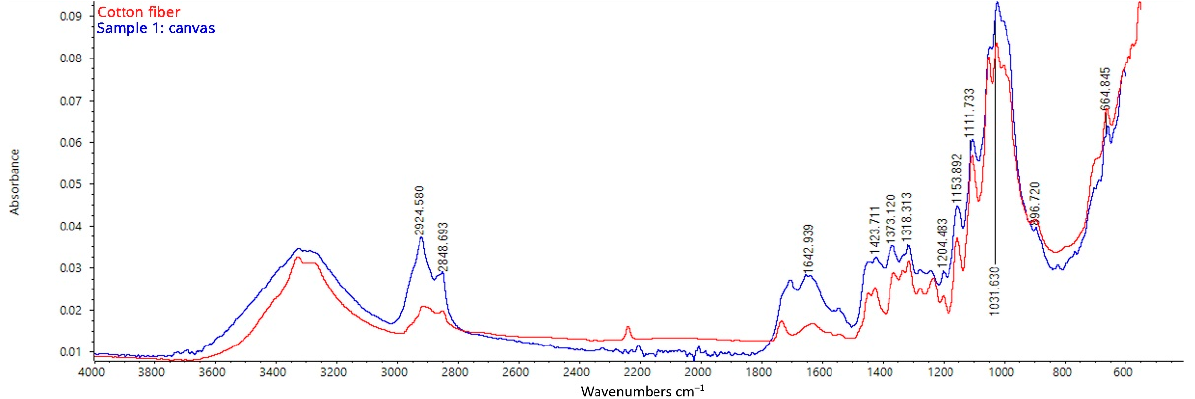
Figure 9. FT-IR ATR spectrum acquired on the backside of sample 1, consisting of the original canvas, the preparation layer, the primer, the paint layers, and the varnish: analysis of the backside of the canvas.